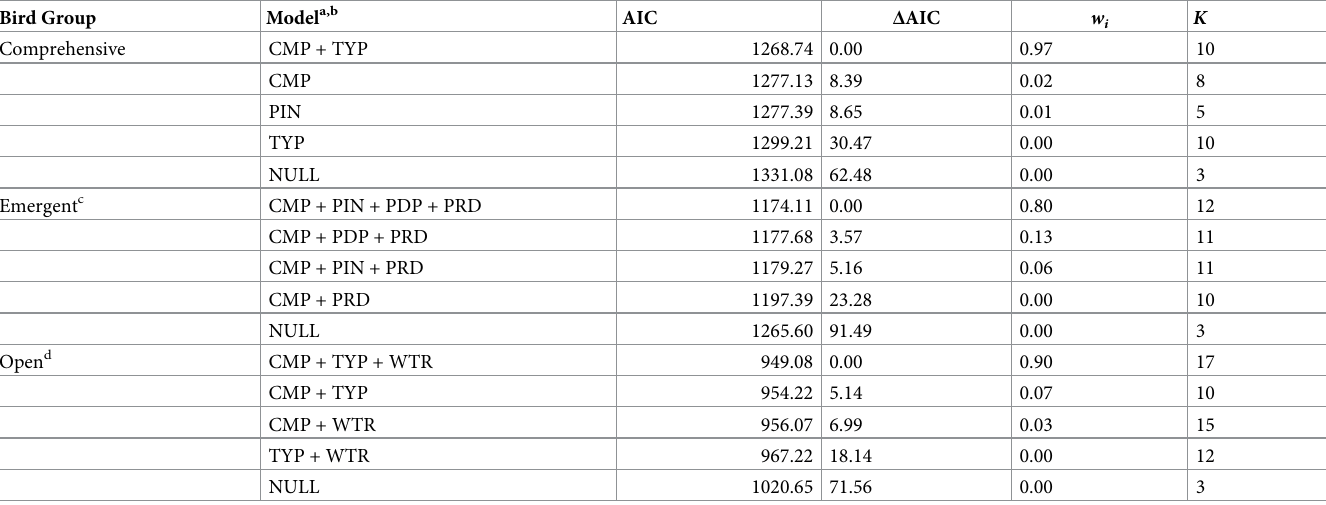
Table 3. Model rankings for variables predicting occupancy probability by species groupings of marsh birds based on Akaike’s Information Criterion (AIC), differ- ence in AIC relative to the highest-ranked model ( Δ AIC), relative model weight ( w i ), and number of parameters ( K ) from surveys conducted at wetlands throughout Illinois during late spring and early summer 2015–2017.